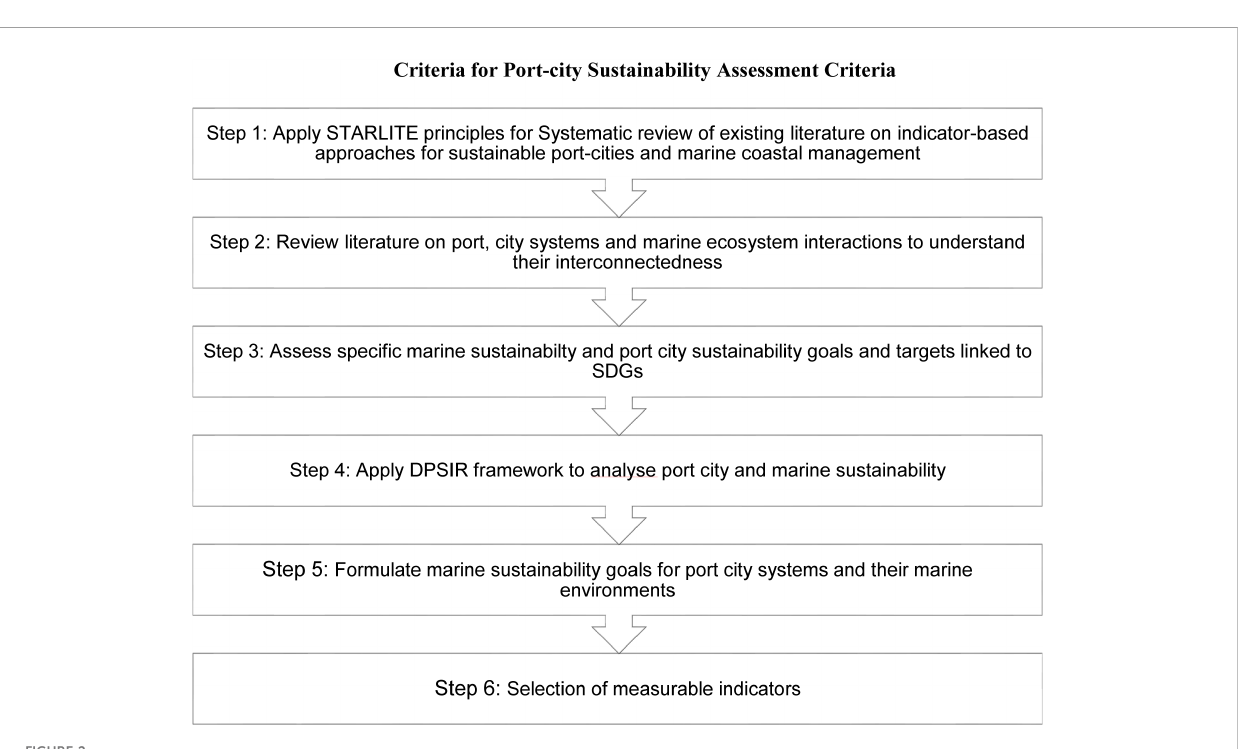
FIGURE 2 Work fl ow of criteria for port-city sustainability assessment